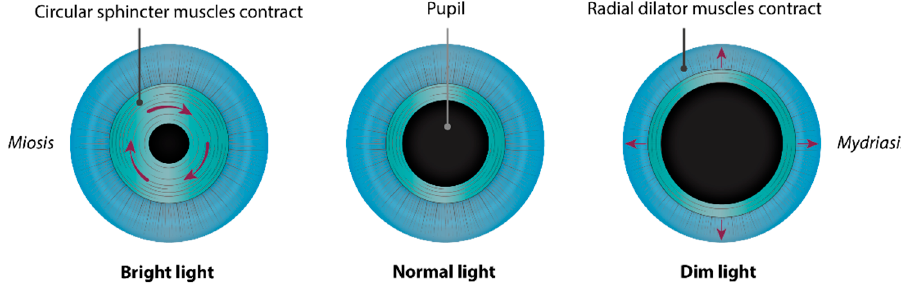
Figure 1. Muscles of the iris and adaptation of pupil aperture to light intensity. The circular sphincter muscle, or pupillary constrictor, near the pupil margin is composed of smooth muscle cells, which can constrict the pupil ( miosis ) when exposed to bright light. It works in opposition to the radial dilator muscle fibers, whose contraction expands the pupillary aperture ( mydriasis ) in a dim environment. The sphincter and dilator muscles are innervated by the parasympathetic and sympathetic nervous systems, respectively.